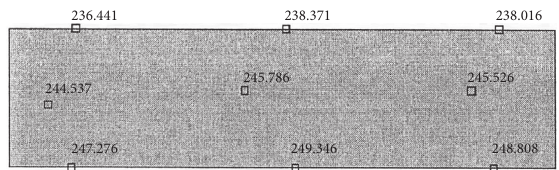
Figure 3: Calculated values of temperature ( ° S ) in sample No. 3 from the axis to the outer heat-removing